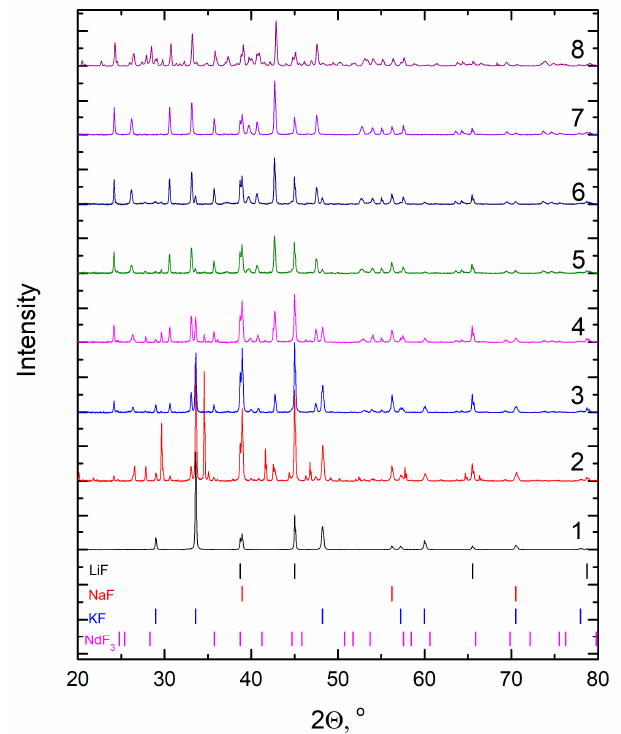
Figure 9. XRD patterns of (1) FLiNaK; (2) FLiNaK + 0.5 mol.% NdF 3 ; (3) FLiNaK + 1.0 mol.% NdF 3 ; (4) FLiNaK + 2.0 mol.% NdF 3 ; (5) FLiNaK + 3.0 mol.% NdF 3 ; (6) FLiNaK + 4.0 mol.% NdF 3 ; (7) FLiNaK + 5.0 mol.% NdF 3 ; (8) FLiNaK + 7.5 mol.% NdF 3 .